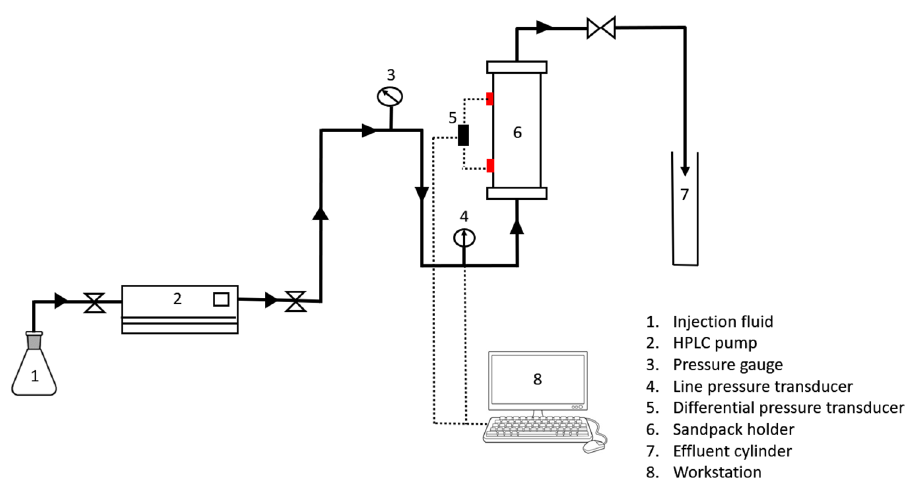
Fig. 6 Schematic of sandpack flow loop